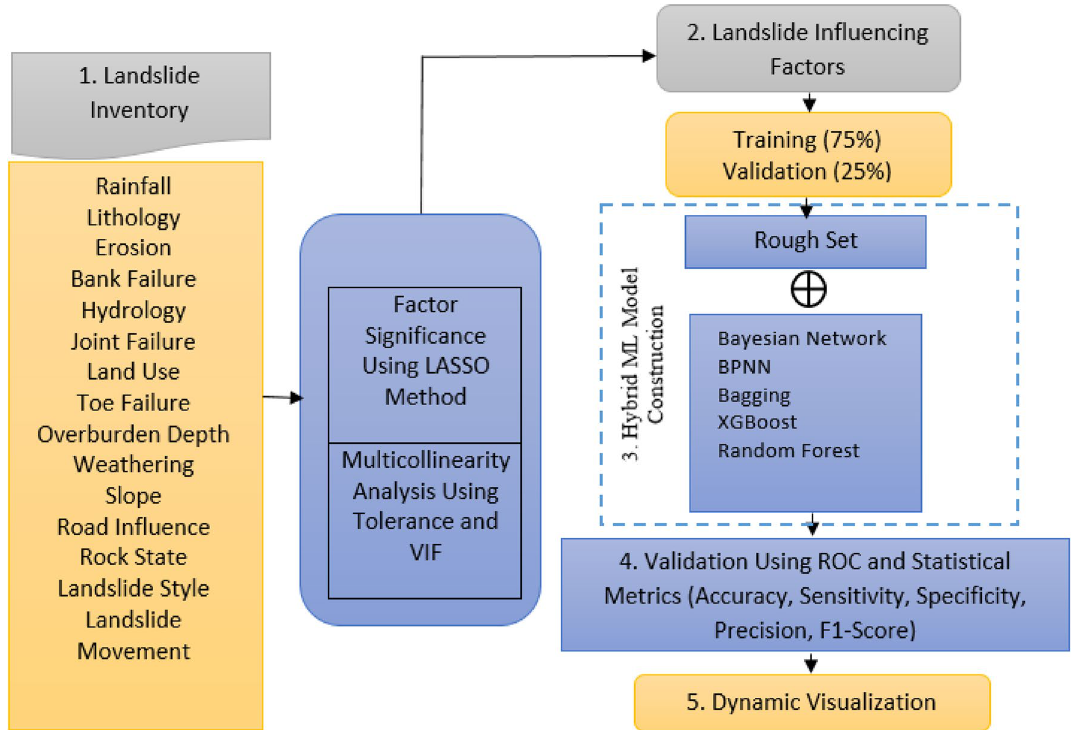
Figure 2. Methodological flowchart showing different steps for the construction of hybrid machine learning models for the prediction of landslide events supported by LASSO